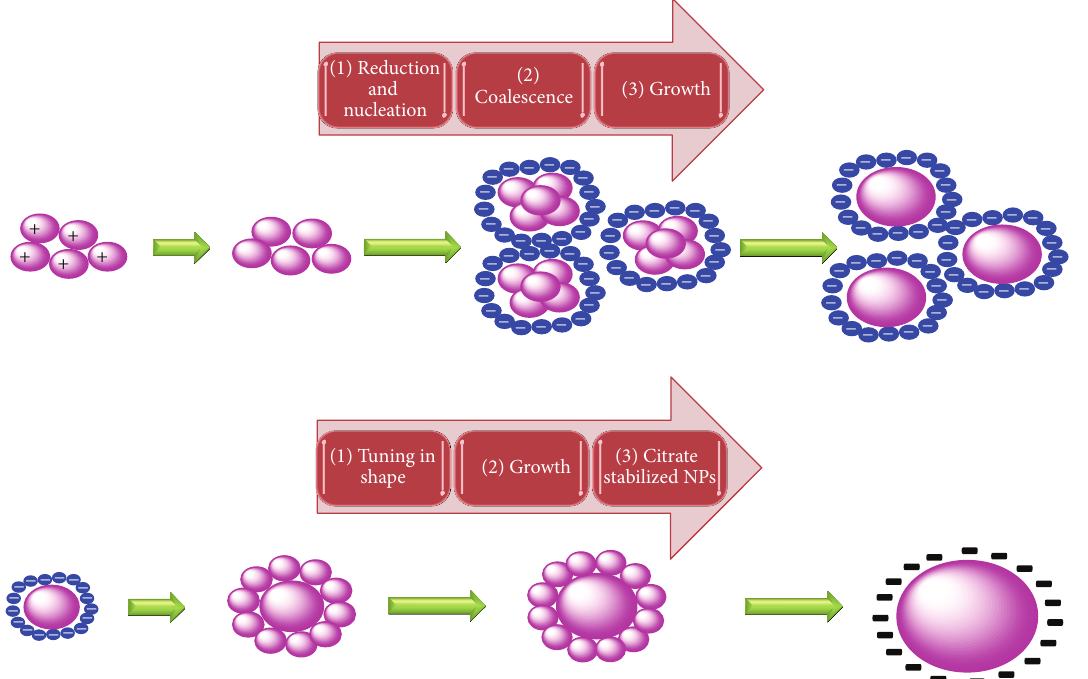
Figure 1: Schematic representation of size controlled synthesis of Ag-NPs using coreduction method.